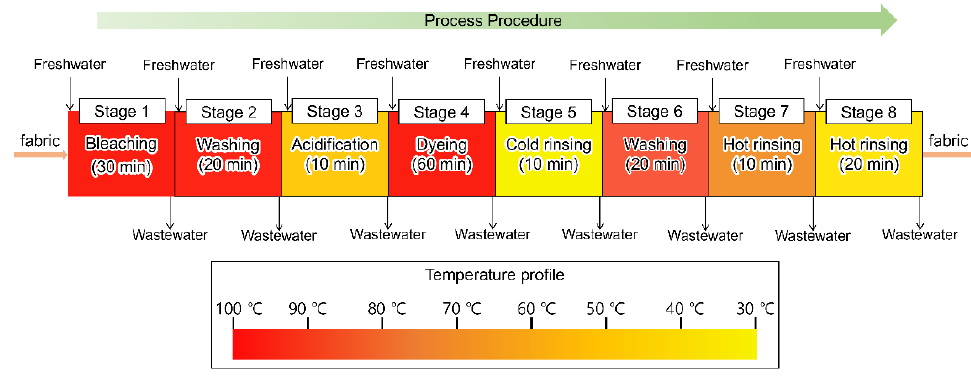
Figure 1. Flow chart of the dyeing process.